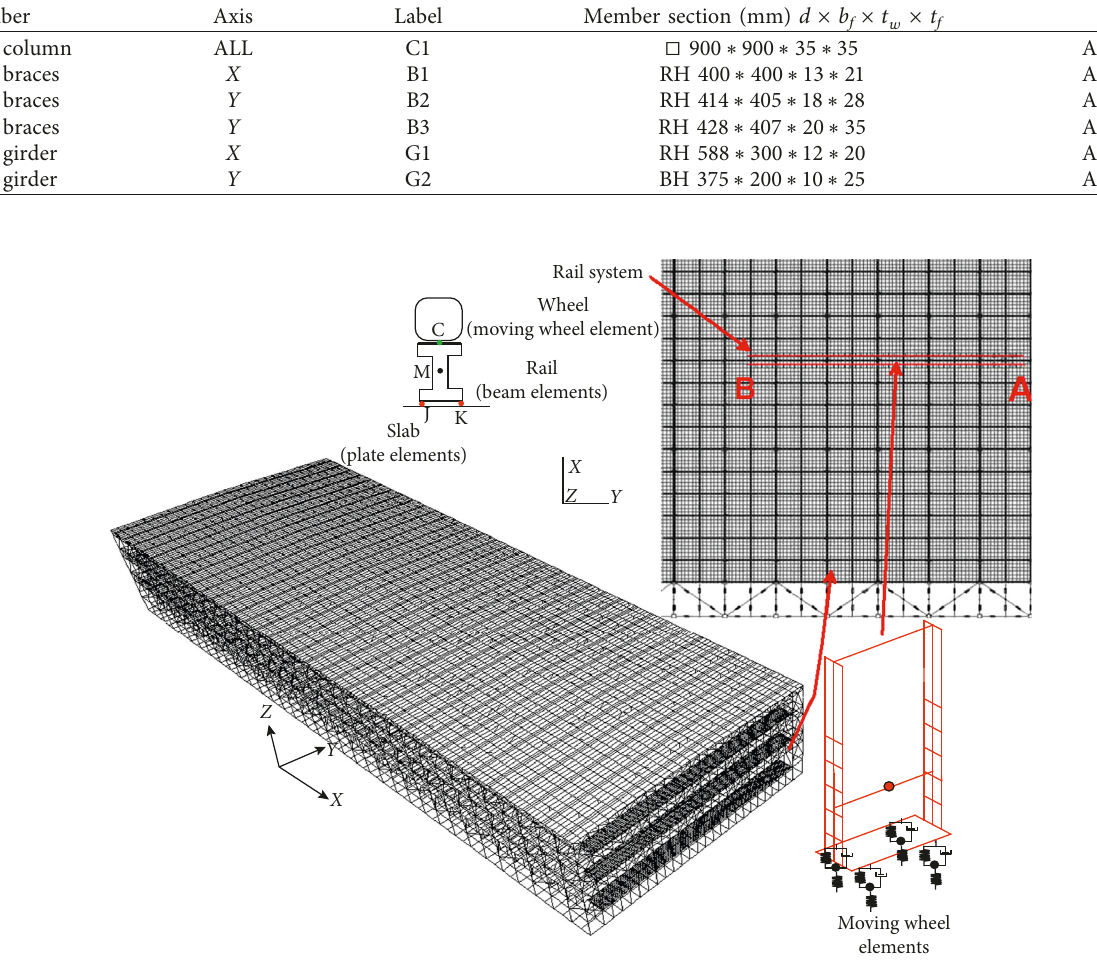
Figure 6: Finite element model including the high-tech factory, rails, crane, and slabs (nodes J, K, and C are slave nodes controlled by the master node